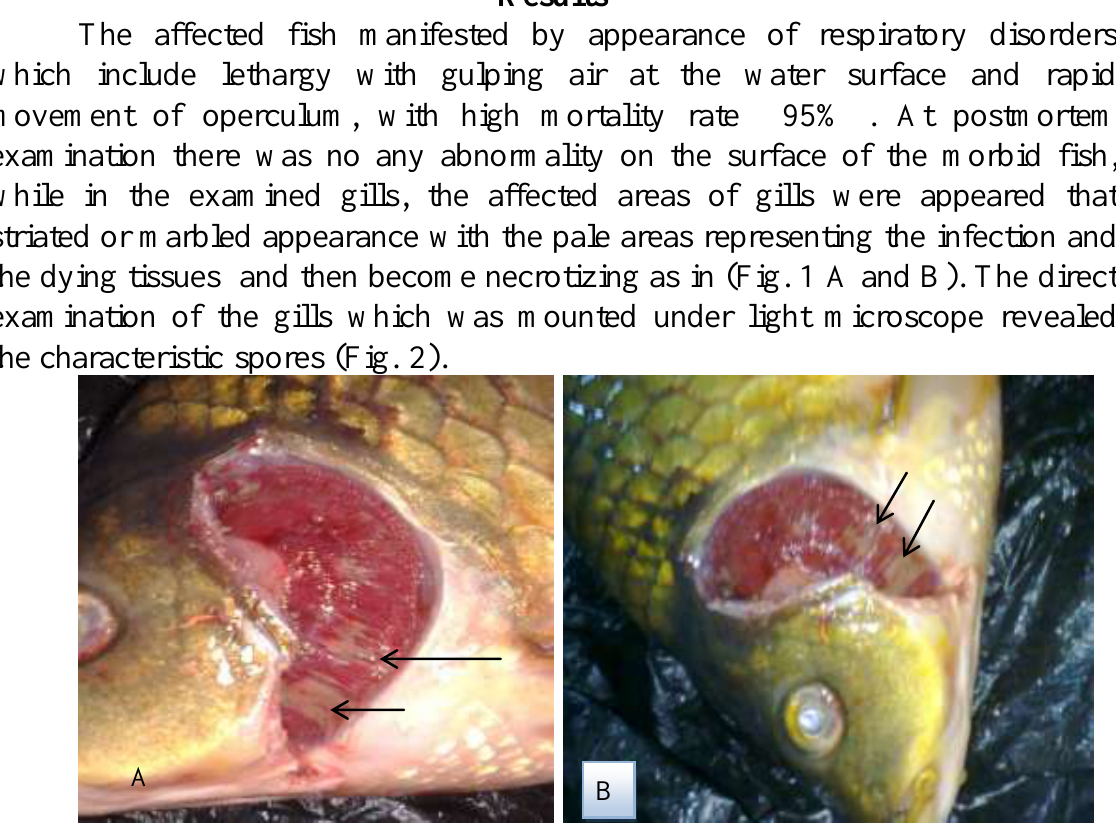
Figure 1 (A, B): Cyprinus carpio infected with Branchiomyces species showing marbled appearance with the pale and necrotizing areas